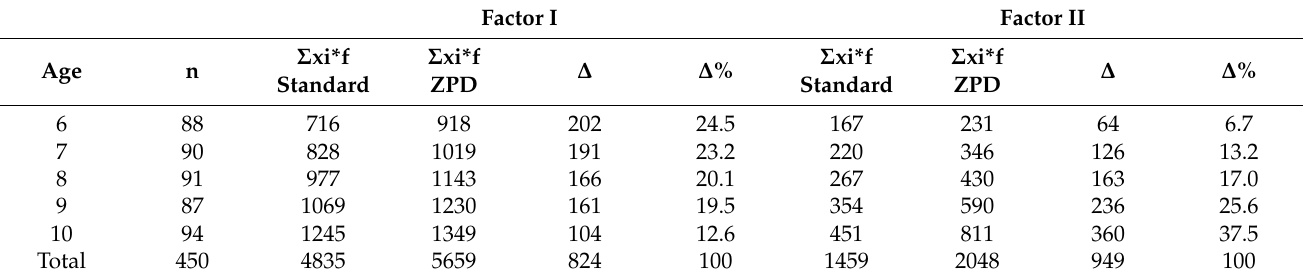
Table 4. Increase in Factor I and Factor II: differences between the sum modalities multiplied by frequencies in the standard and in the ZPD conditions in absolute and percentage values. Factor I Factor